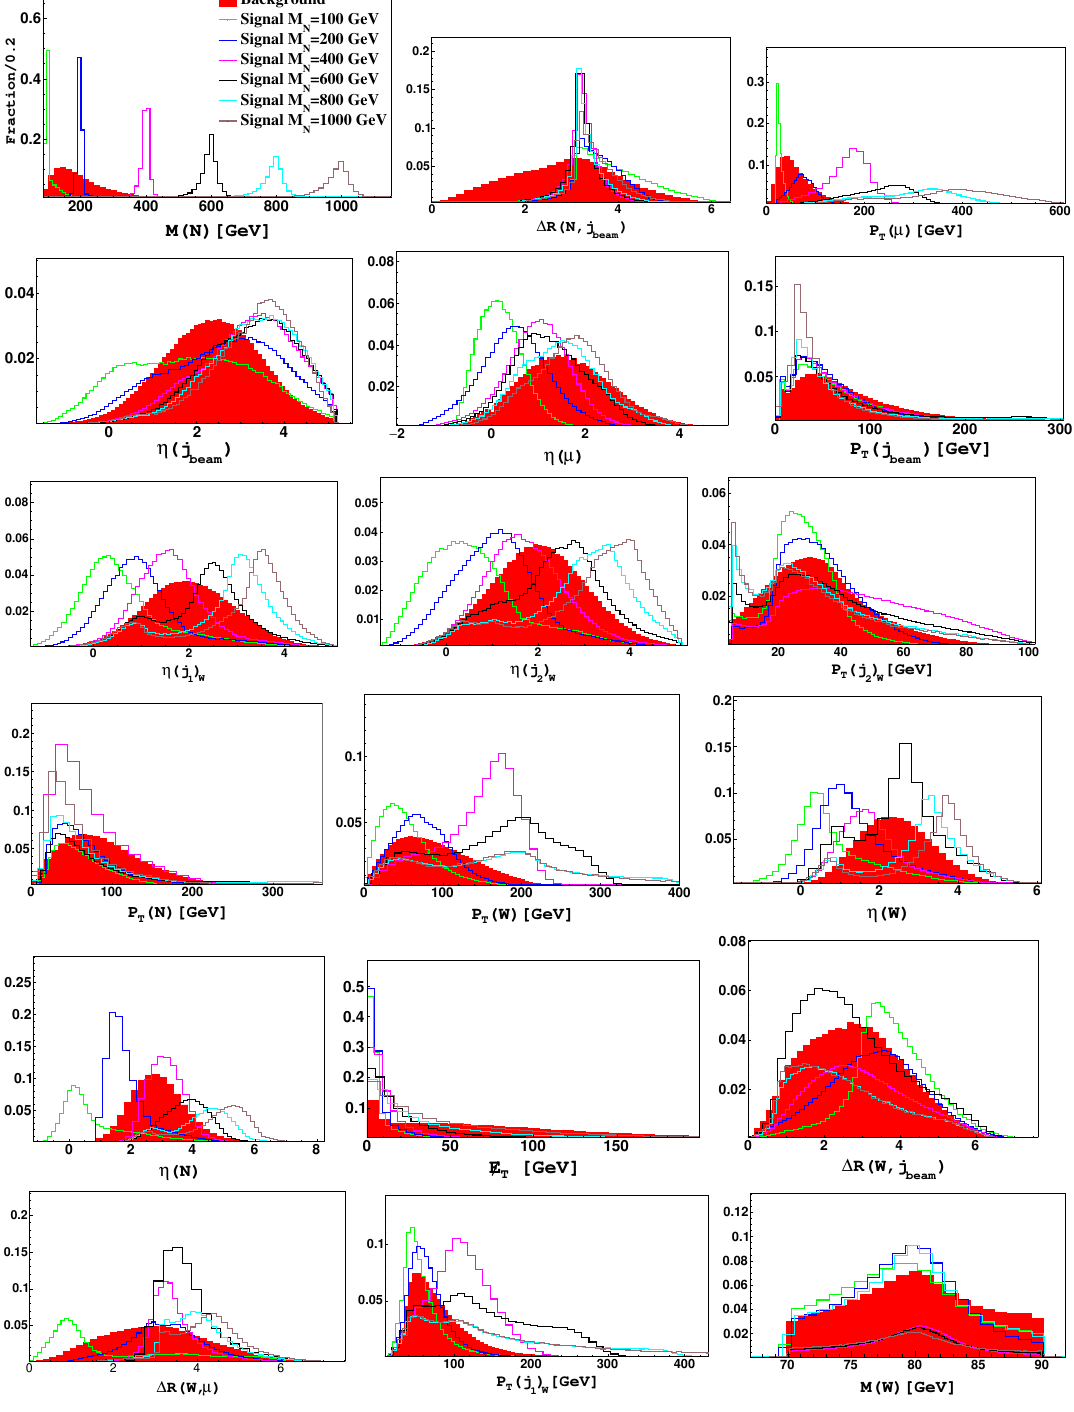
Figure 3 . Kinematical distributions for the 6 signal benchmark points and all the backgrounds summed at the LHeC. Color coding and normalization are uni(cid:12)ed for all (cid:12)gures.